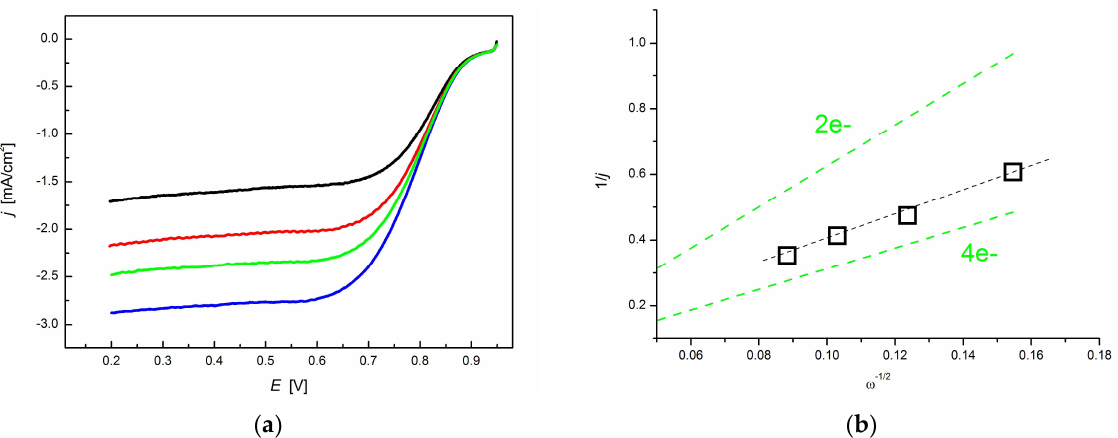
Figure 11. ( a ) Linear sweep voltammograms of CA sample (100 µg/cm 2 ) measured in O 2 -saturated 0.1 M KOH solution with a rotating disk electrode (RDE). Rotation rates: 400 (black), 625 (red), 900 (green), 1225 rpm (blue). Sweep rate: 5 mV/s; ( b ) Koutecky–Levich plot from the linear sweep voltammetry responses at 0.30 V. The theoretical KL slopes of the 2e − and 4e − routes are shown for comparison.